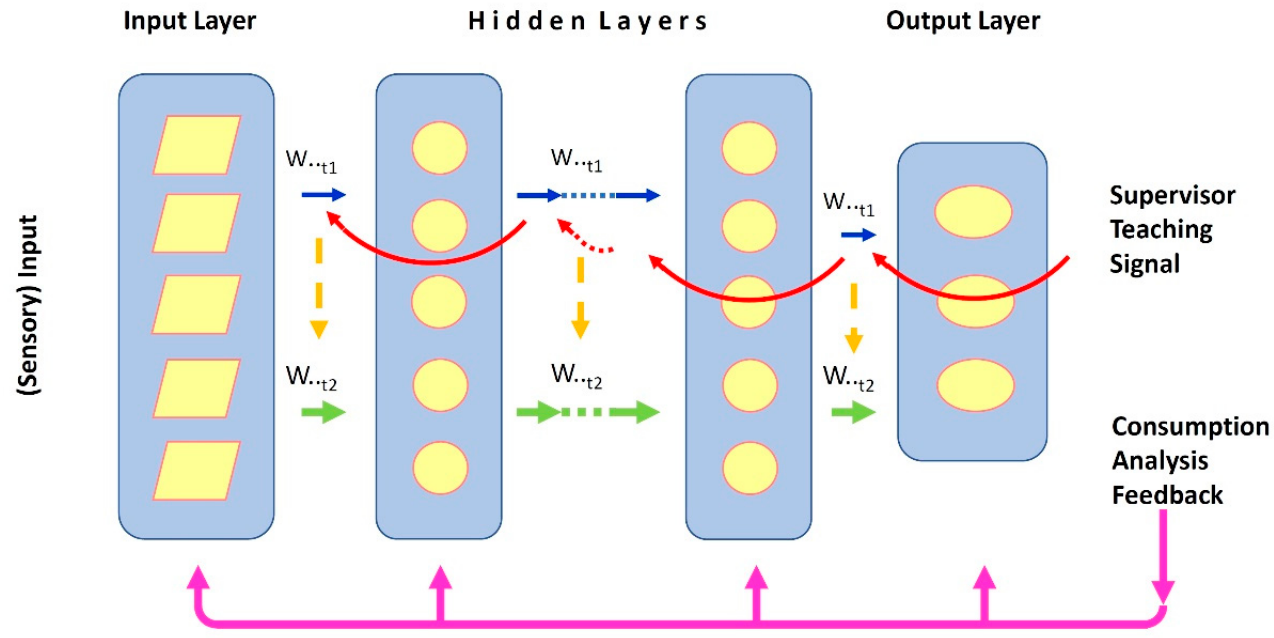
Figure 2. Beginning with first connections, weights are tuned based on teaching signals propagating backwards from output to input neural layers in standard back propagation (red arrows). With one globally distributed monitoring signal (magenta) it is possible to reach and, especially during subsequent occasions, tune input layers in a fully biological plausible way. Optimized (green) connections and their associated weights most likely turn out very similar in limited domains; deriving relevant details is work in progress.